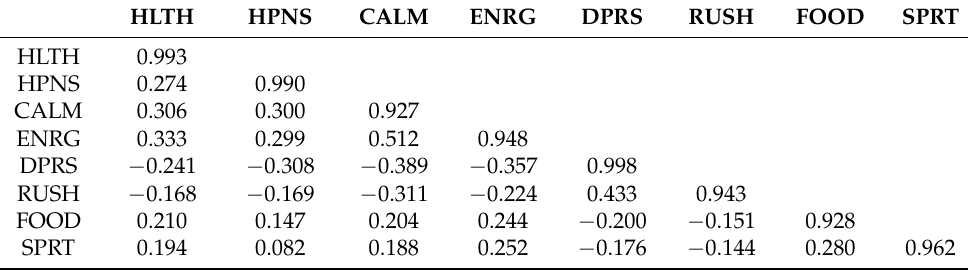
Table 3. The covariance